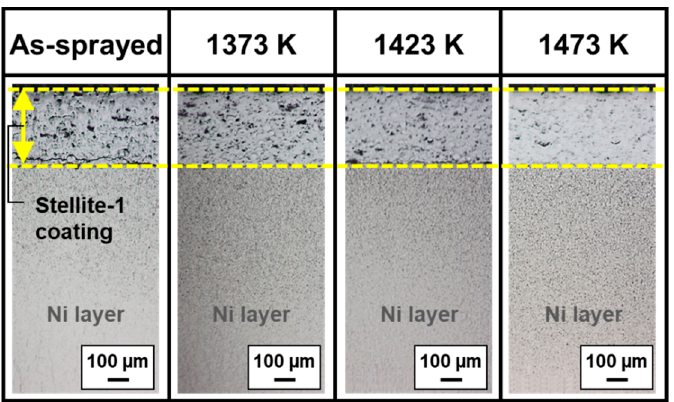
Figure 6. Cross-sectional macrostructures as functions of the heat treatment temperatures.